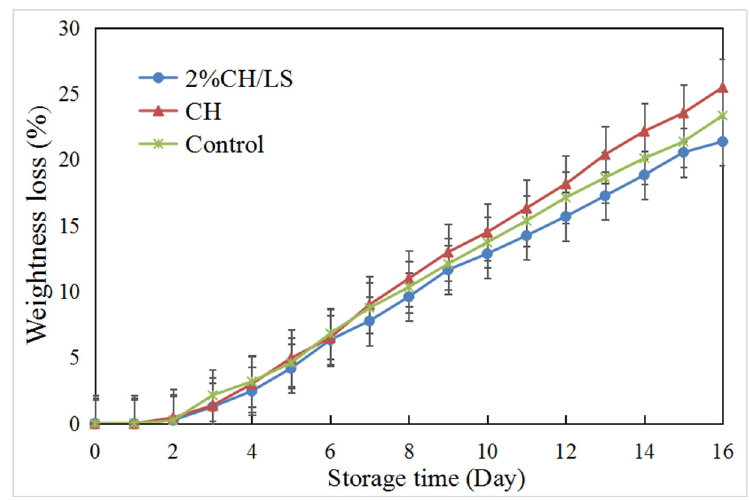
Figure 3. Weight loss rate of grapes during preservation with different packaging films.